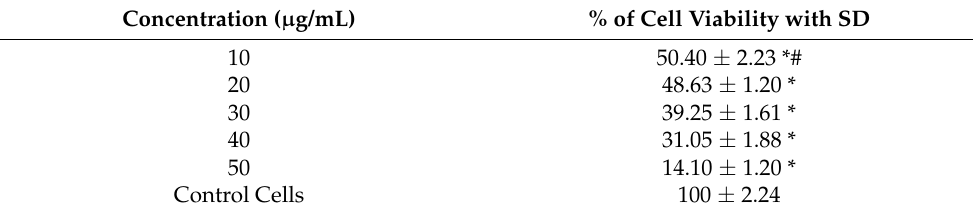
Table 1. Cytotoxic effect of ketamine against PC 12 cell line and determination of IC50.